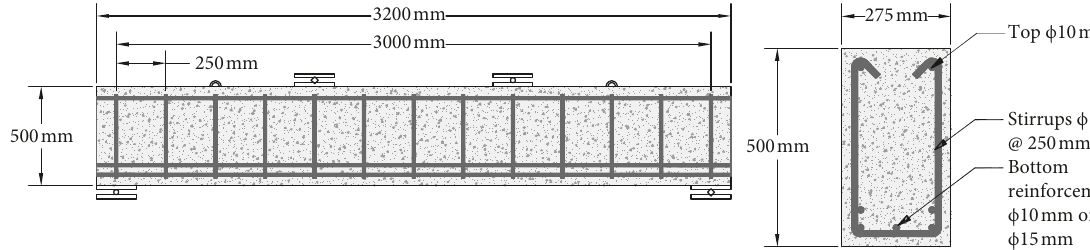
Figure 1: Beam configuration and cross section [11].